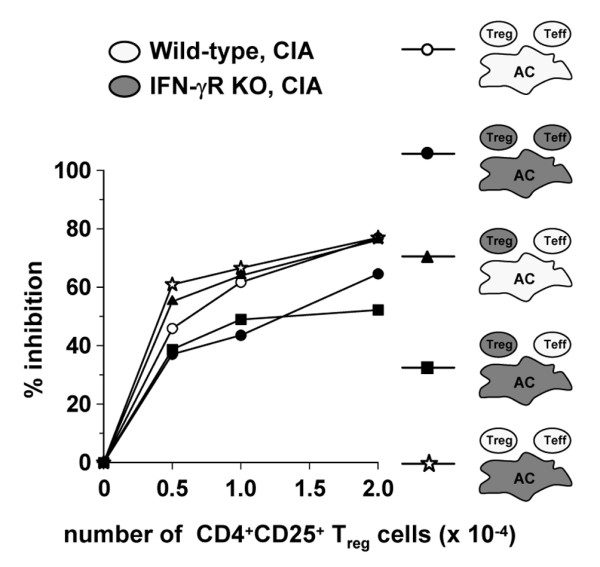
Accessory cells (ACs) of immunised IFN-γR KO mice are required for their defective Treg activity. Treg cells, Teff cells and ACs were isolated from lymph nodes and spleen of IFN-γR KO and wild-type DBA/1 mice 21 days after immunisation with collagen type II in complete Freund's adjuvant. Mixing experiments were performed as indicated. In each set, 5 × 104 CD4+CD25- Teff cells were incubated with anti-CD3 antibody in the presence of ACs and the indicated number of CD4+CD25+ Treg cells. The percentage inhibition of the proliferation of Teff cells (CD4+CD25-) by increasing numbers of CD4+CD25+ Treg cells is shown. The results are representative of two independent experiments.